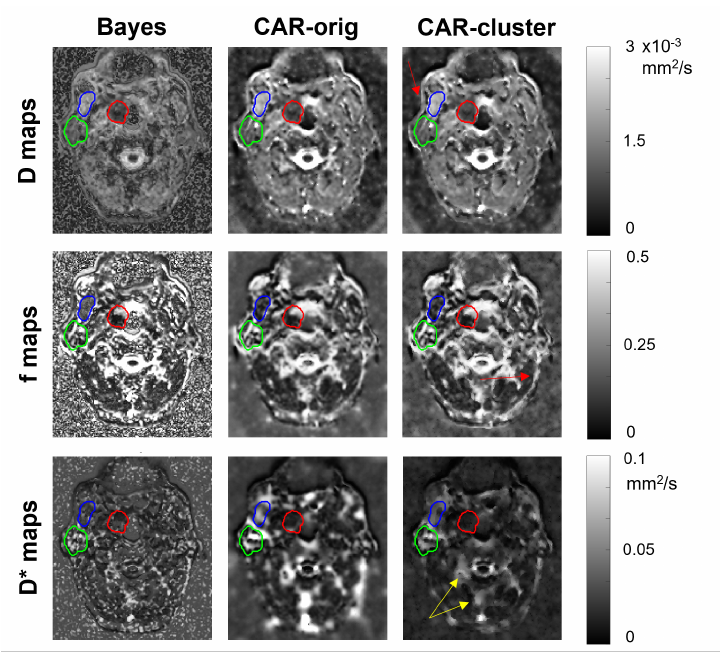
Figure 5. Parametric maps of D ( first row ), f ( second row ) and D ∗ ( third row ), estimated from a selected slice of a HN patient using the three methods (columns). The tumor, the parotid gland and the masticatory muscle are delineated in red, green and blue, respectively. Red arrows indicate improvement in boundary definition, yellow arrows indicate reduced blurred